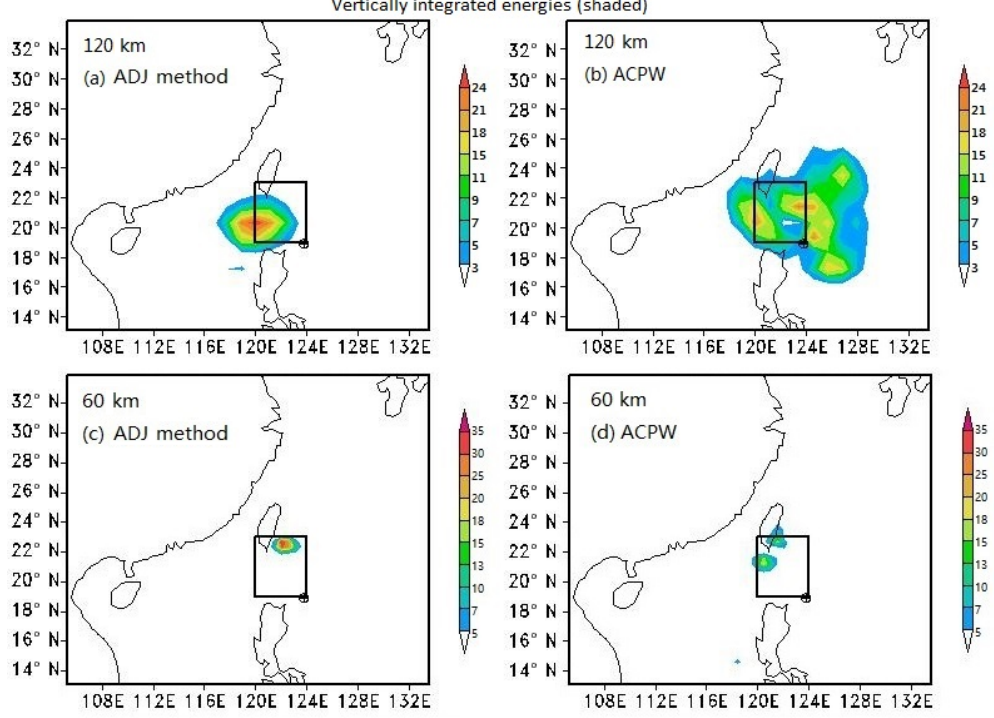
Figure 8. As described in Fig. 6, except where the shaded parts represent the vertically integrated energies (units: Jkg − 1 ).